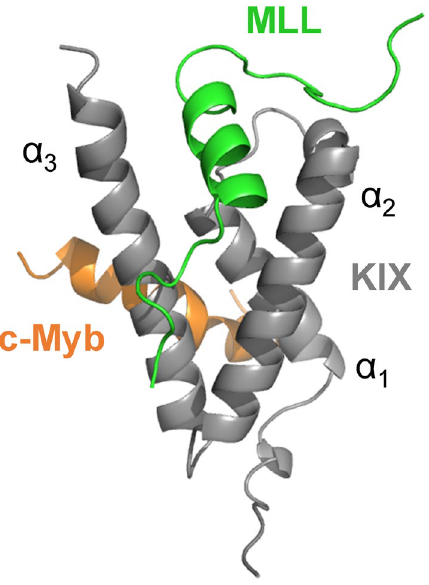
Figure 1. Structure of the KIX:MLL:c-Myb ternary complex. The c-Myb and MLL sites are located at the hydrophobic grooves between helices α 1 and α 3 and between helices α 2 and α 3 of KIX, respectively (PDB